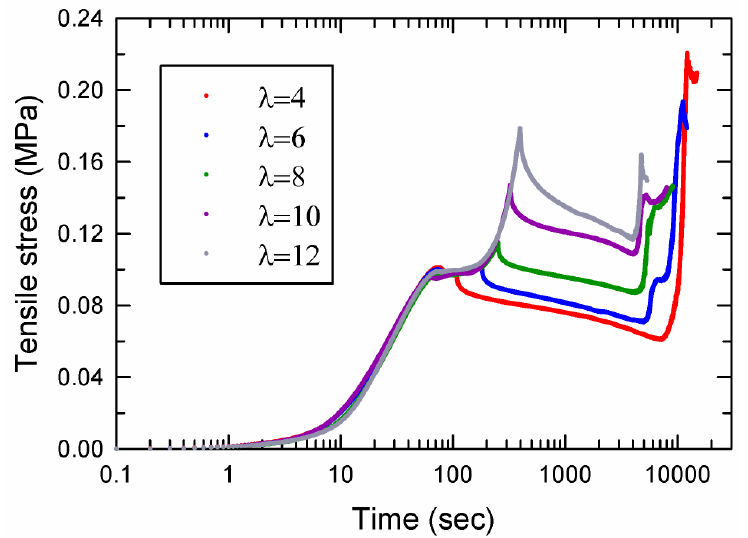
Figure 5. Results of drying experiments (tensile stress versus time) for AMPS(1,2,2,9)/AAm (2,0.1,0.01,97) DN hydrogels with various stretch ratios. Water sorption experiments were conducted with the dried samples of the AMPS (1,2,2,9)/AAm(2,0.1,0.01,97) DN hydrogels stretched to the different extension ratios. Figure 6 shows a segment of the dried hydrogel sample stretched to λ = 12 and after being rehydrated to the equilibrium swelling ratio.